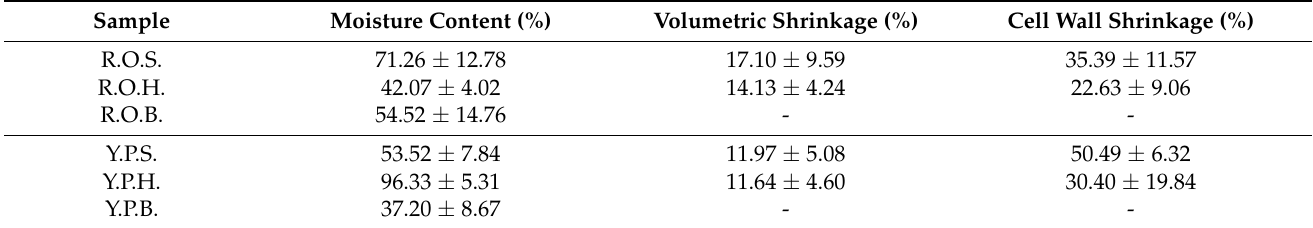
Table 1. Mean ± standard deviation ( n = 6) values for moisture content, volumetric shrinkage, and cell wall shrinkage of green, red oak, and yellow-poplar components. Sample Moisture Content